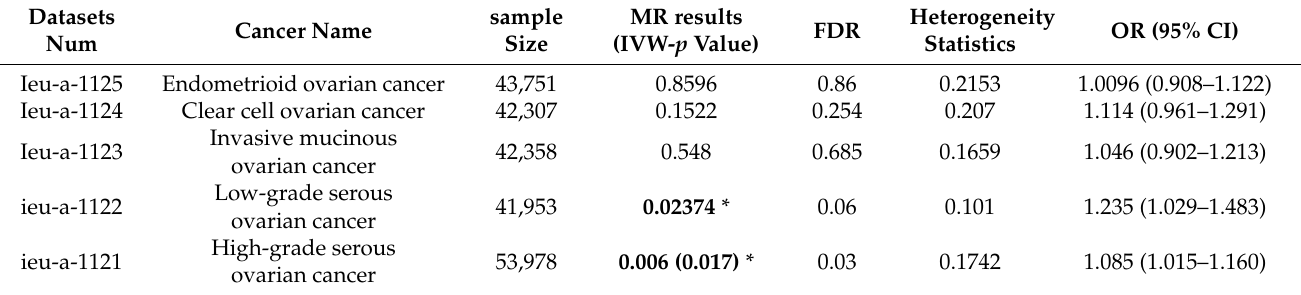
Table 2. The 2SMR results of SCZ and five subtypes of ovarian cancers using IVW